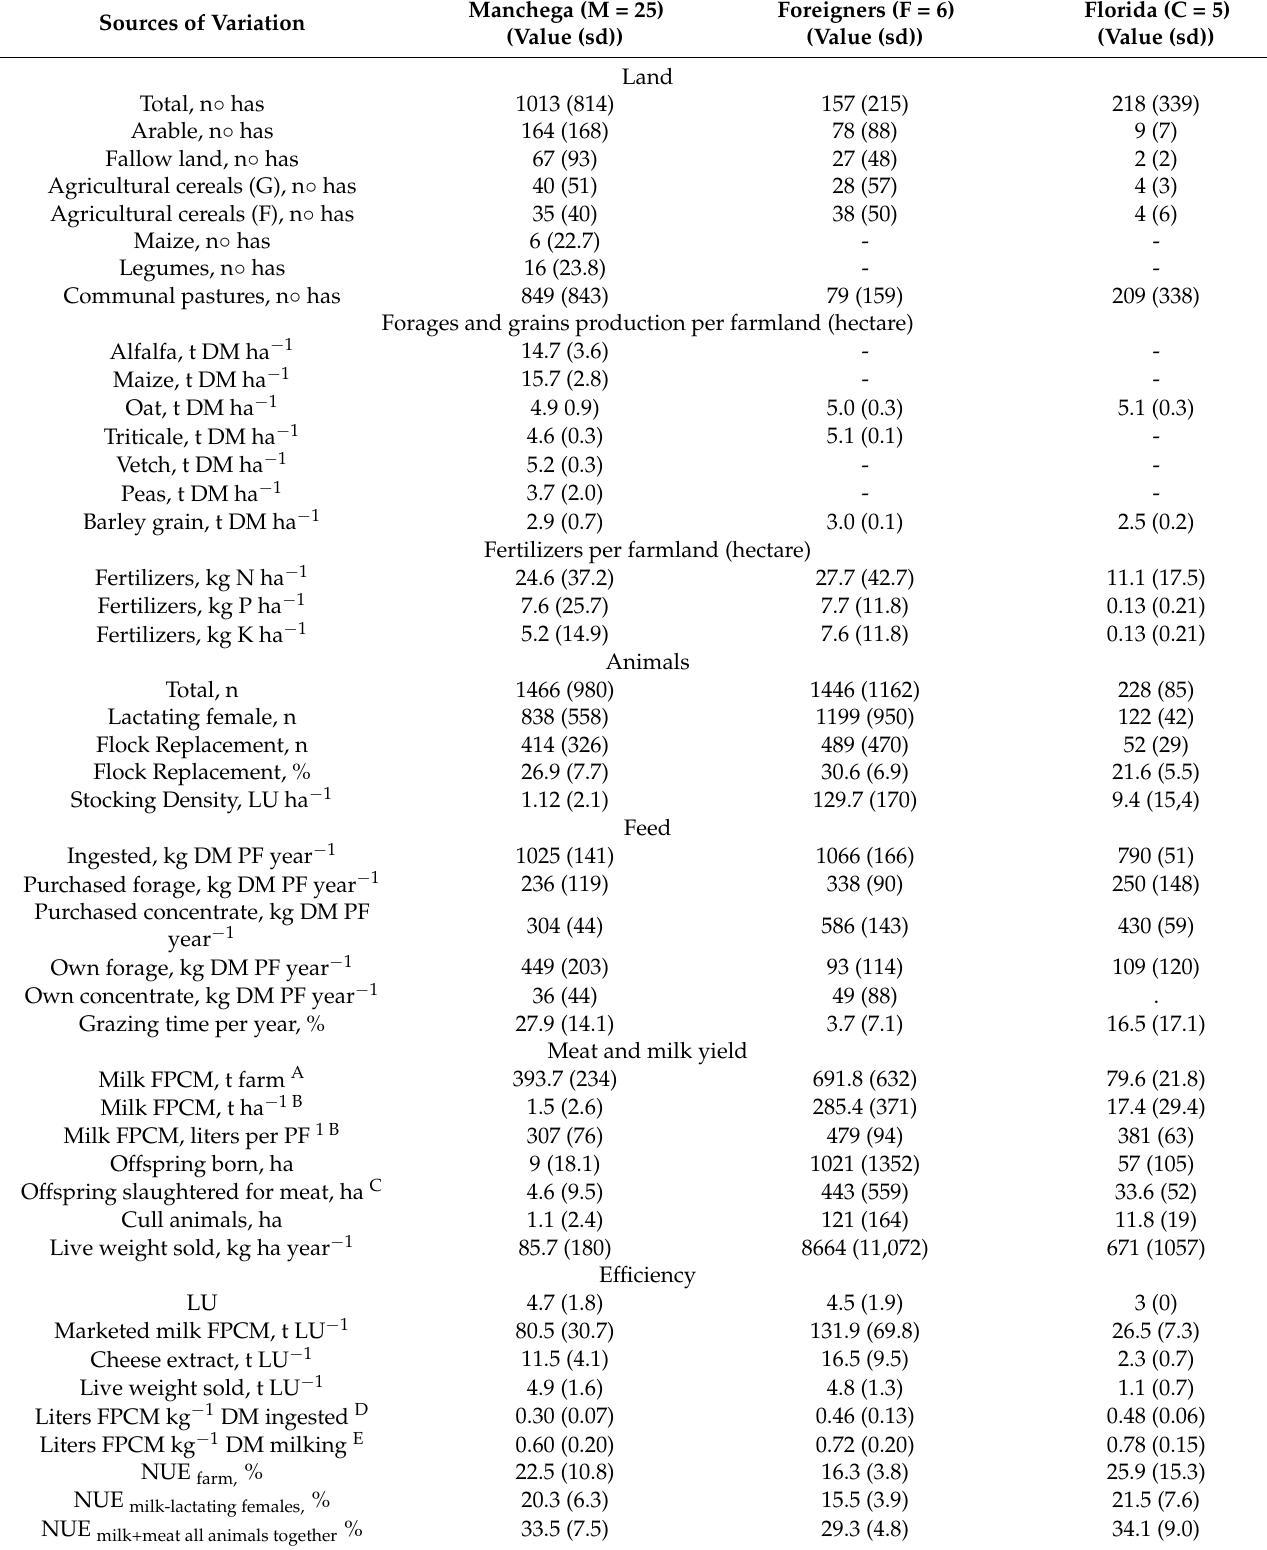
Table 3. Technical and productive features at farm level ( n = 36